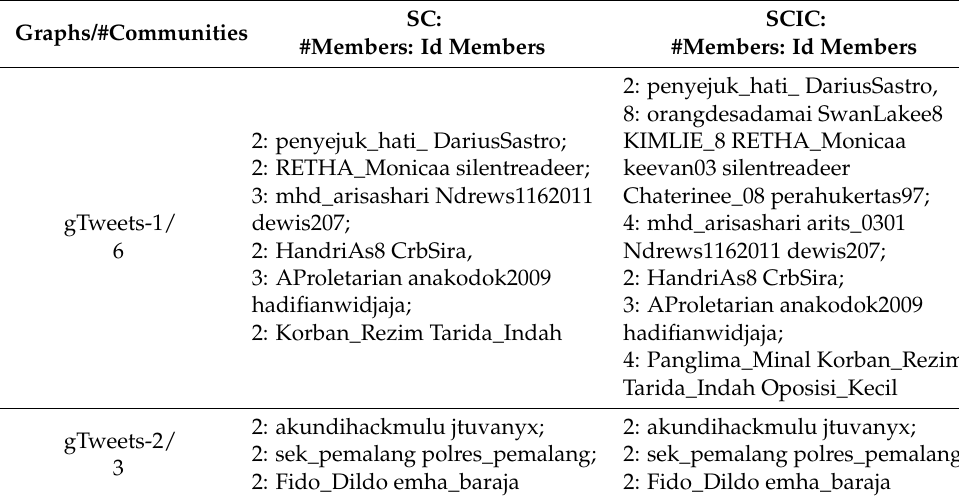
Table 5. SC and SCIC discovered from 2 graphs.